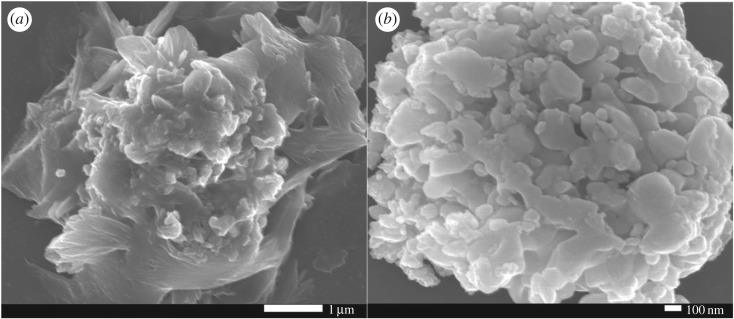
SEM images of the (a) CuO/ZnO and (b) 1% In2O3–CuO/ZnO sample.